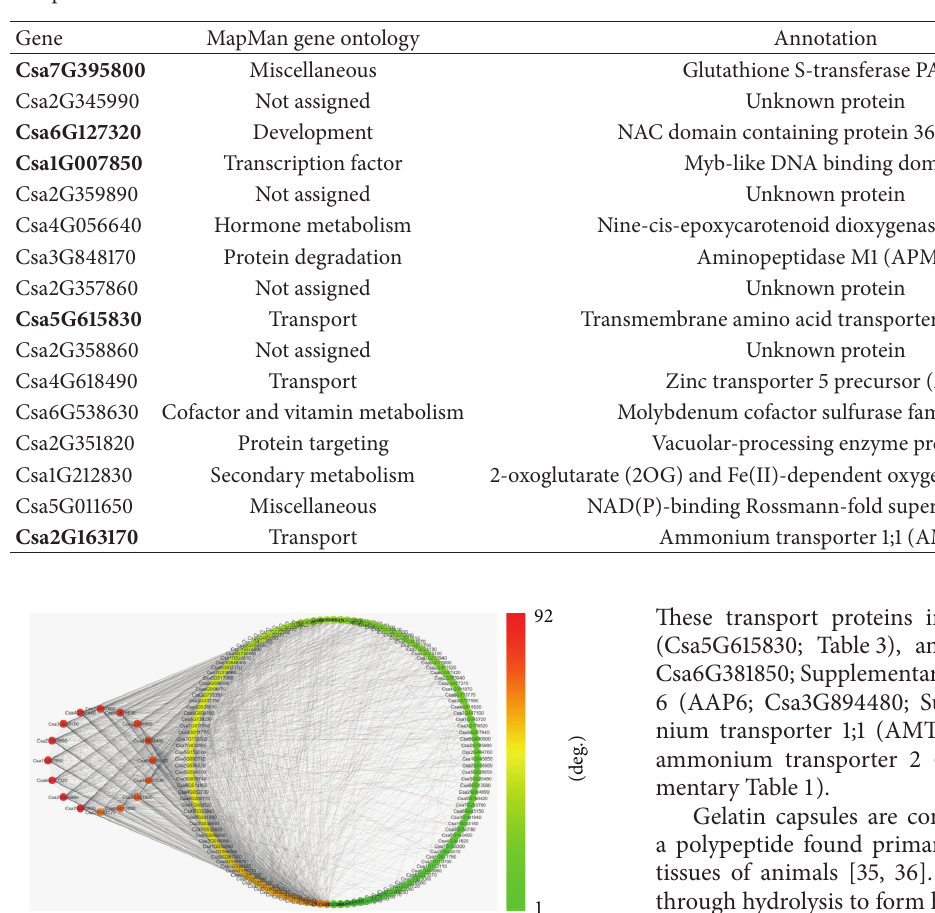
Table 3: List of 16 network hub genes identified in the blue module. Degree represents the number of edges between genes, which represent coexpression correlations.